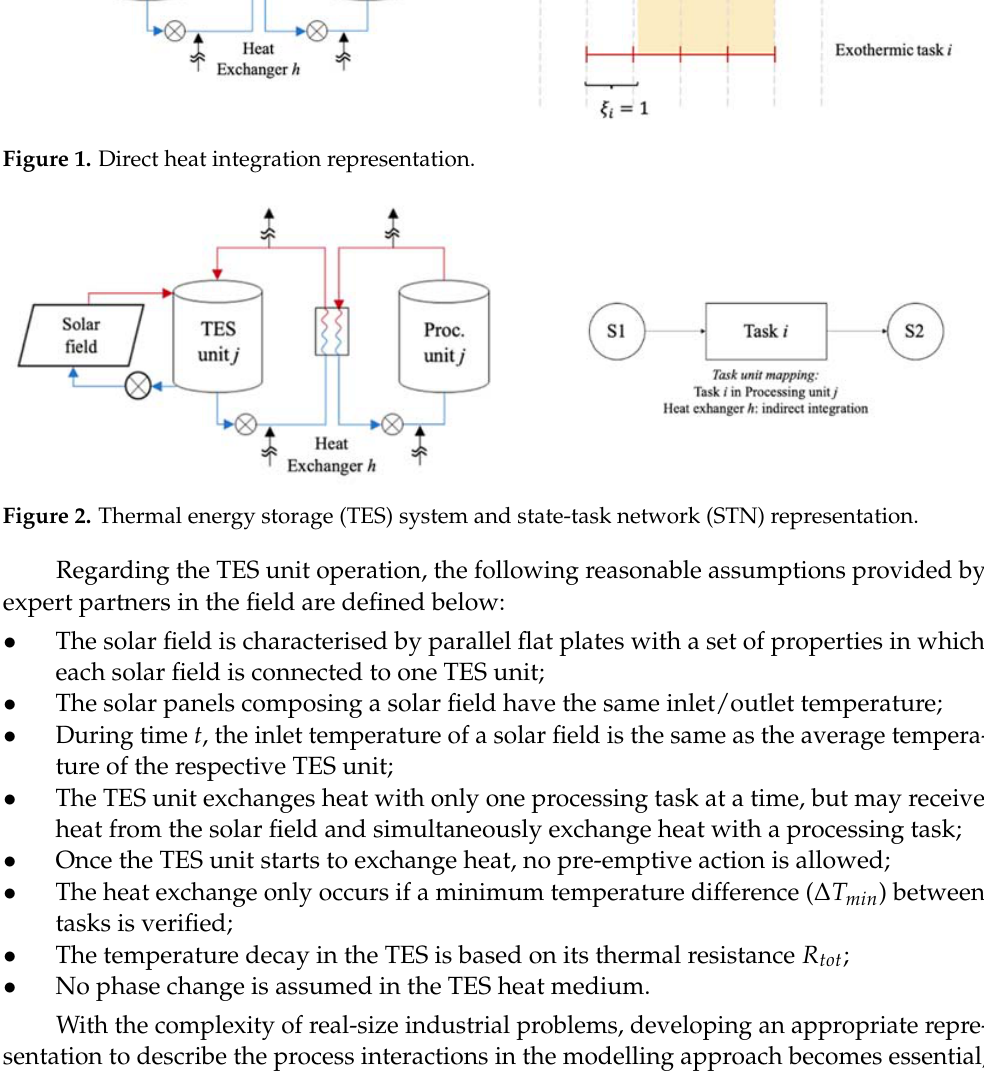
Figure 1. Direct heat integration representation.